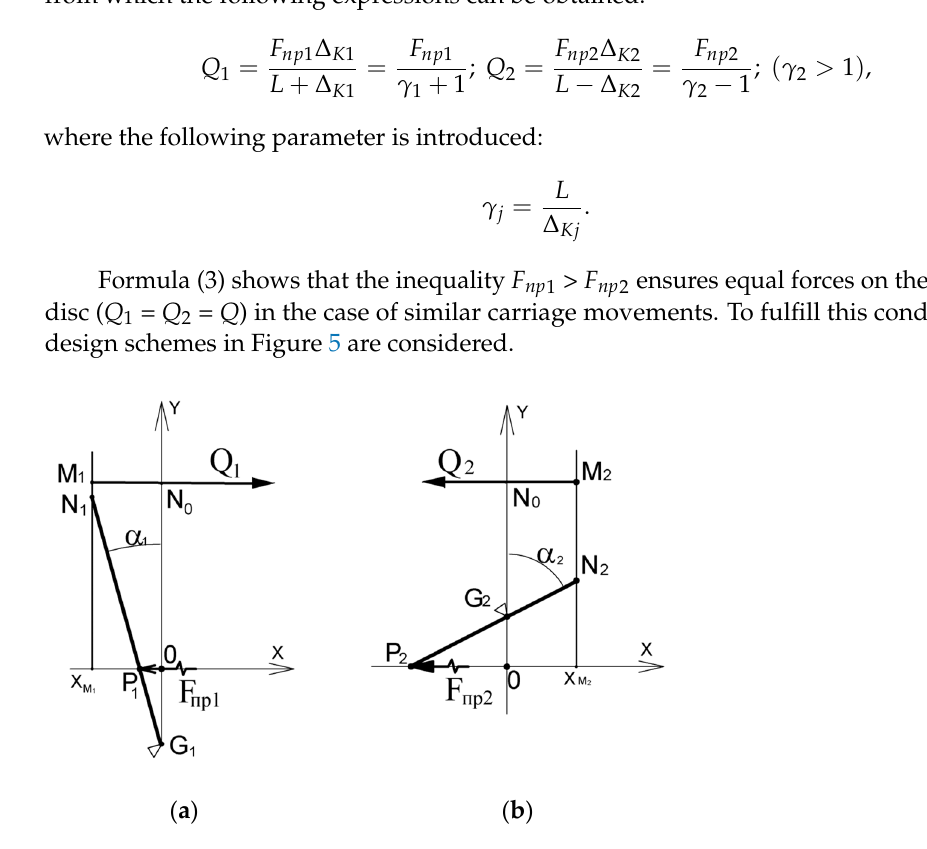
Figure 5. The design schemes of the switched-on DCT: ( a )—1st clutch; ( b )—2nd clutch.